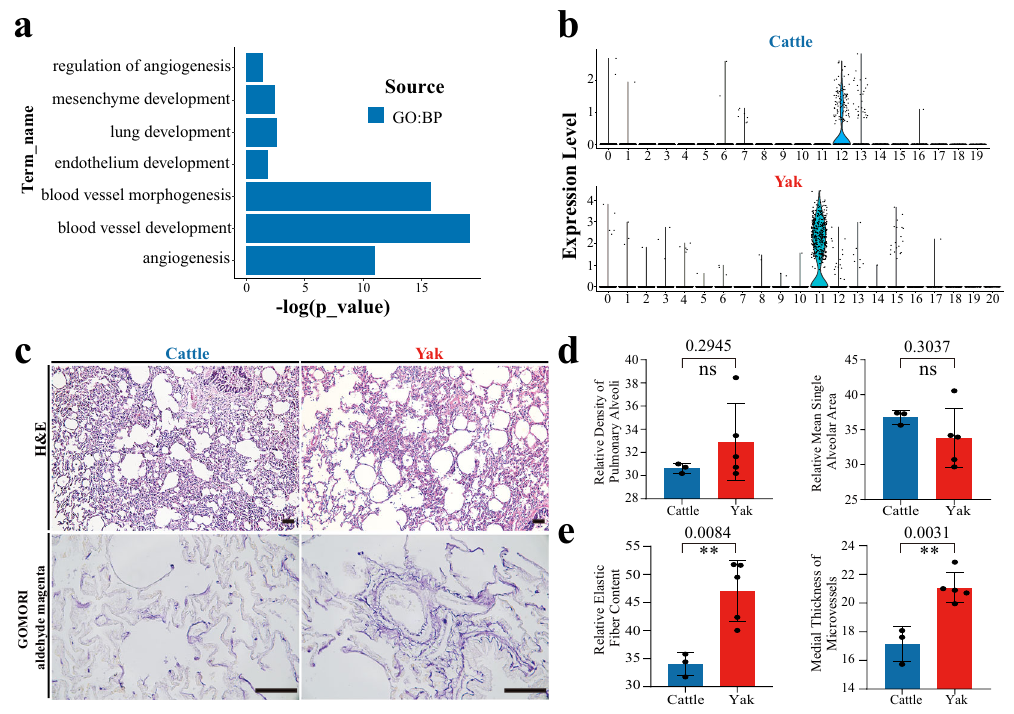
Fig. 4 | Gene expression and histological analysis of the domestic yak and taurine cattle lungs.a Enrichment analysisof DEGs in different mesenchymal cell cluster, statistical analysis was performed using a hypergeometric test. b Violin plots of the patterns of LOX expressions in the domestic yak ( n =5 biologically independent samples) and taurine cattle ( n =5 biologically independent samples) lungatthesinglecelllevel. c H&Eandelastic fi berstaininginthedomesticyak( n =5 biologically independent samples) and taurine cattle lung ( n =3 biologically inde- pendentsamples).Scalebar=50 μ m. d Quanti fi cationsofthedensityofpulmonary alveoliand relative meansingle alveolarareainthe domesticyak( n =5biologically independent samples, 33.81±3.80 in relative mean single alveolar area, 32.89±3.00 in relative density of pulmonary alveoli) (ns, no signi fi cance; T-test,